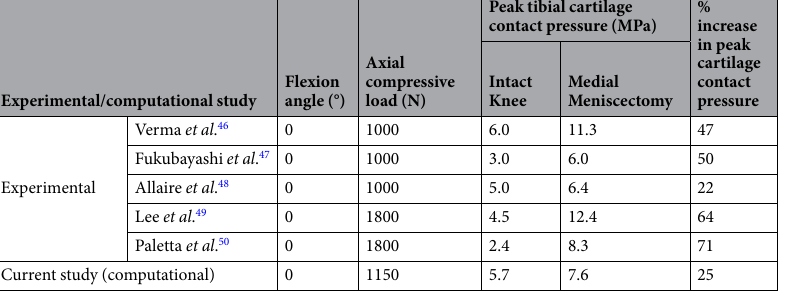
Table 4. Comparison of the peak tibial cartilage contact pressure in the current study and the experimentally measured values available in the